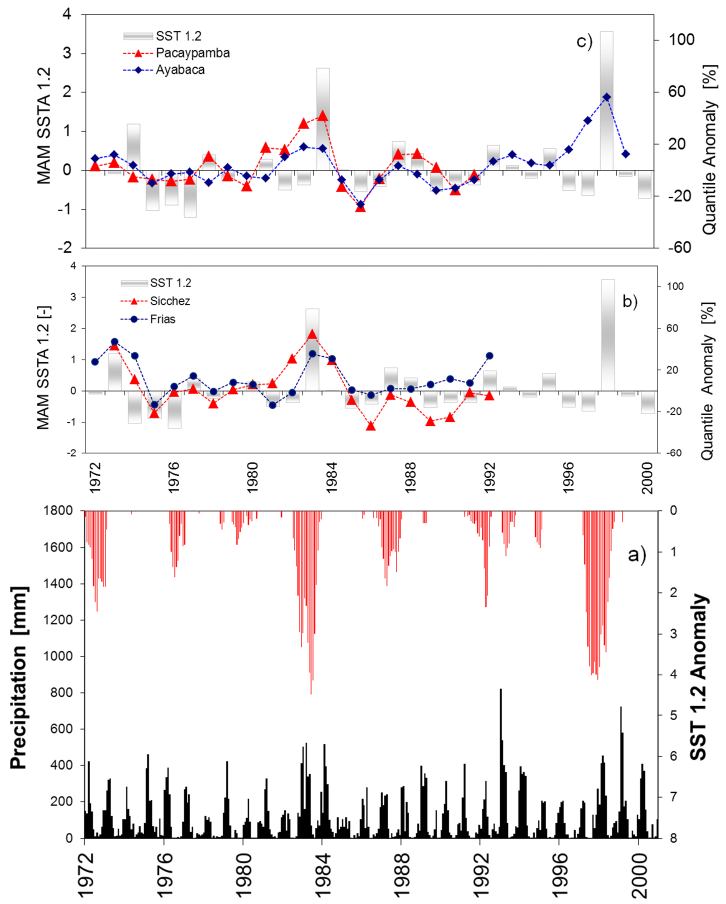
Fig. 5. (a) Series of monthly precipitation at Ayabaca (2700m) and positive SSTA 1.2. (b) MAM precipitation quantile anomaly for a 2-yr block at Sicchez (1400m) and Frias (1700m). (c) Same as before but for Pacaypamba (1960m) and Ayabaca